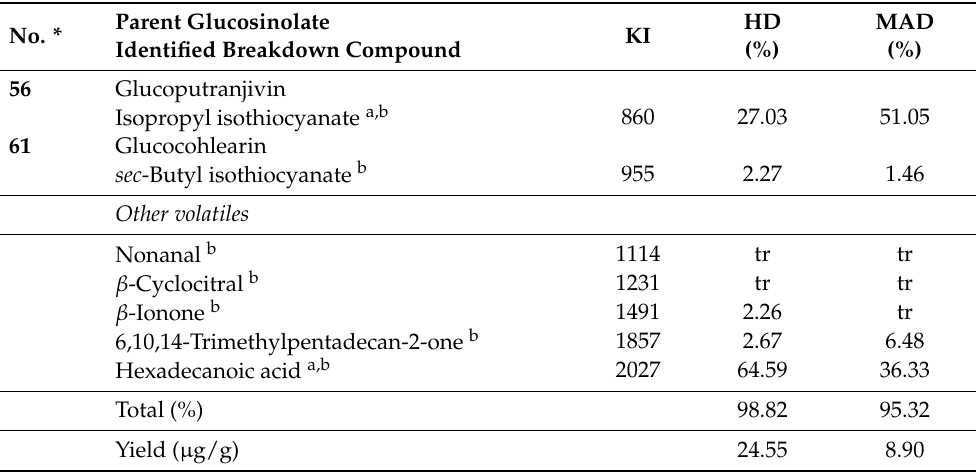
chromatograms are given in Figure S1 (Split sample) and Figure S2 (Krka sample), while MS 2 spectra are given in Figure S4. tr—traces; n.d.—not detected; DW—dry weight of plant material. Data are expressed as the mean value ± standard error ( n = 3). Table 2. Volatiles obtained from aerial parts of S. officinale from Split using different methods of